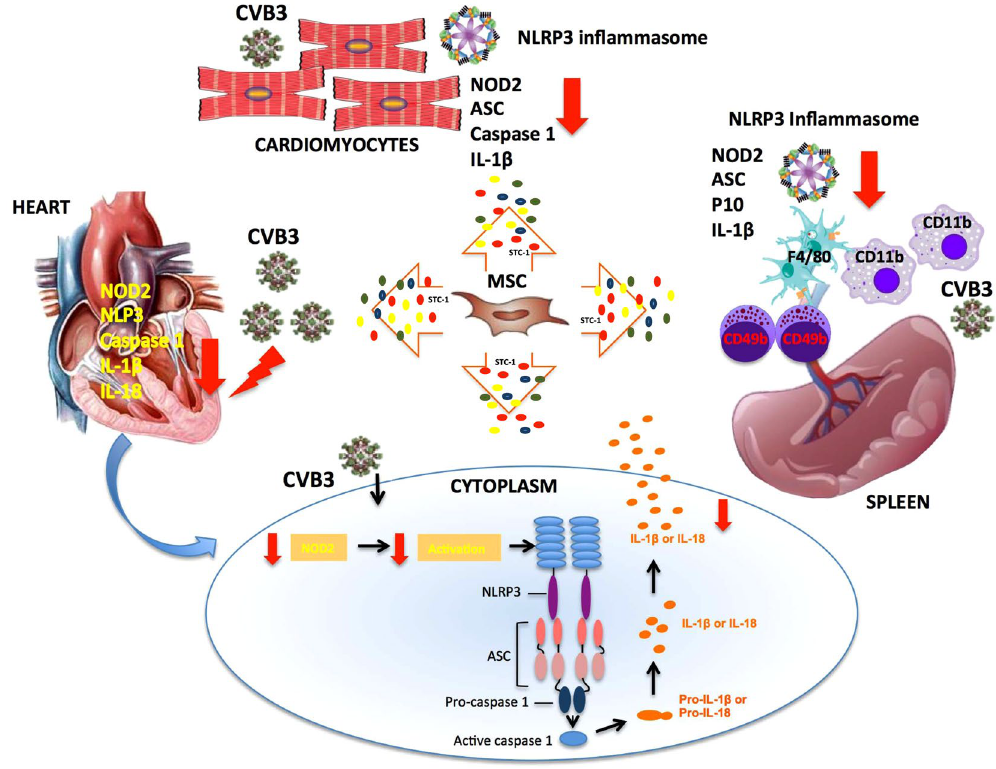
Figure 8. Hypothetical scheme of the effect of MSC application on NLRP3 inflammasome activation in the heart and innate immune cells of Coxsackievirus B3-infected mice. MSC application abrogates the expression of NOD2 and NLRP3 inflammasome components NLRP3, ASC, caspase 1 and IL-1 β and IL-18 in the heart of CVB3-infected mice. The inhibitory effect of MSC on CVB3-induced inflammasome activation in cardiomyocytes was confirmed in vitro as indicated by a reduction in NOD2-, ASC-, and caspase 1-positve CVB3-infected cardiomyocytes and subsequent decrease in IL-1 β secretion in the presence of MSC. MSC application mediated a systemic immunoregulation by suppressing NOD2 expression, inhibiting NLRP3 inflammasome activation and IL-1 β secretion by macrophages, natural killer cells, and dendritic cells. MSC exert inhibitory effects on NLRP3 inflmmasome activation presumably partly via suppressing NOD2 expression and partly via secretion of the paracrine factor STC-1. MSC application is an effective strategy abrogating NLRP3 inflammasome activation and preventing the adverse consequences of excessive myocardial and systemic inflammation. All MSC-mediated effects are marked with a red arrow. STC-1 is marked as a red